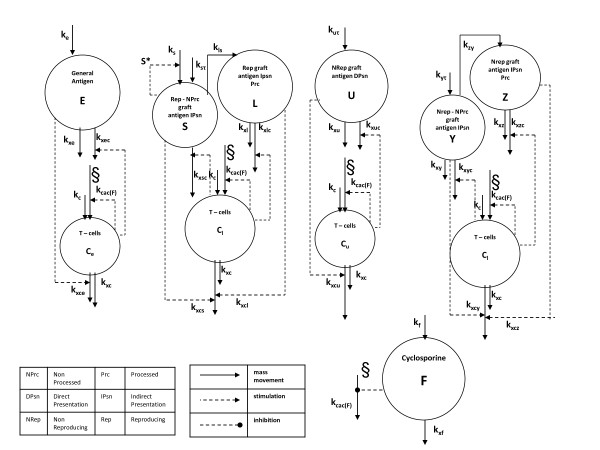
Model block diagram. State variables are represented with circles, the above ones for the different antigen types, the bottom ones for specific T-cells. On the bottom right the pharmaceutical dynamics is represented, the symbol § indicates the site of action of the drug. Solid arrows represent mass transfers, while dashed lines indicate stimulation and inhibition (arrow end and dot end, respectively).